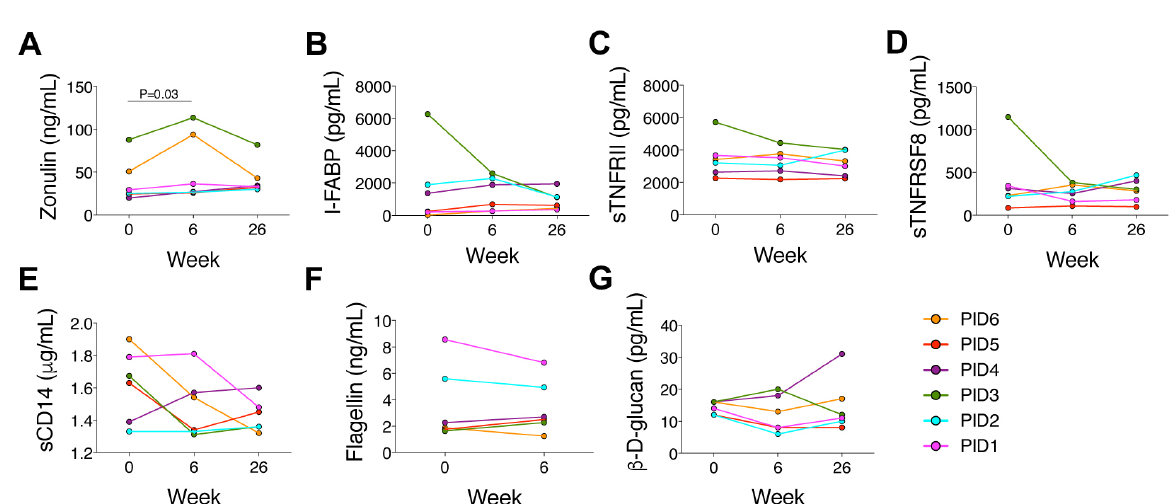
Figure 5. Changes in biomarkers of gut damage (zonulin, intestinal fatty acid binding protein [I-FABP]), microbial translocation (soluble CD14 [sCD14], flagellin, and (1,3)-β-D-glucan), and inflammation (soluble tumor necrosis factor [TNF] receptor II [sTNFRII], and soluble TNF receptor superfamily 8